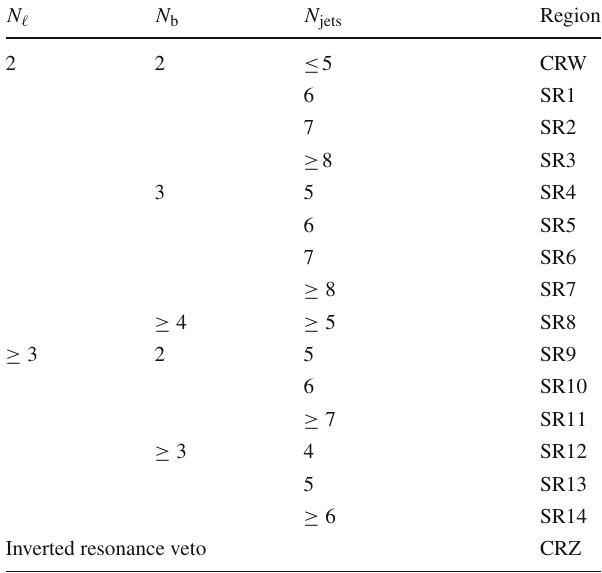
Table1 Definitionofthe14SRsandtwoCRsforthecut-basedanalysis N